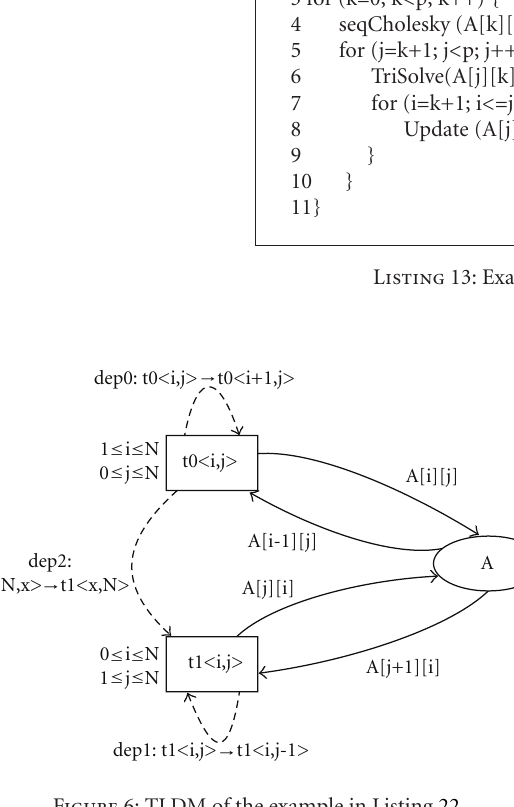
Figure 6: TLDM of the example in Listing